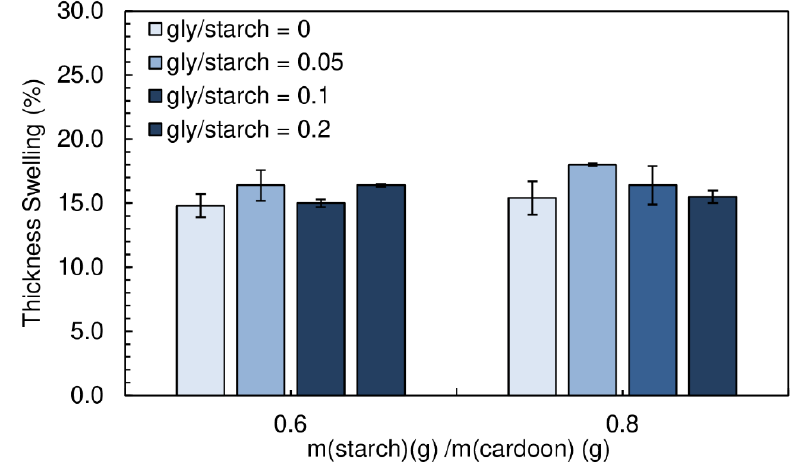
Figure 11. Effect of glycerol content on thickness swelling of the particleboards bonded with a potato starch. All adhesive formulations had a starch/cardoon ratio of 0.6 and 0.8 and cs/starch ratio of 0.05.